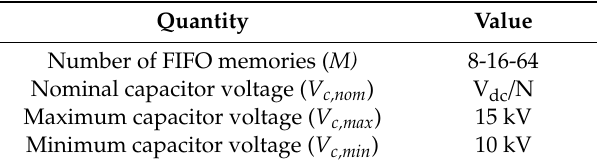
Table 4. Capacitor Voltage Mapping Strategy (CVMS)